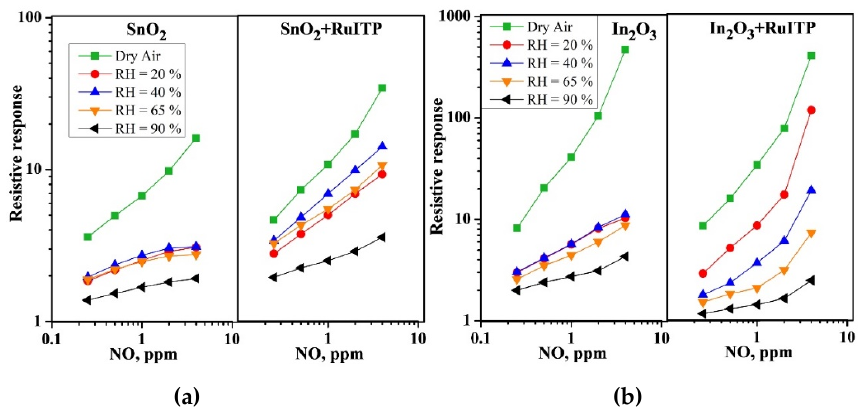
Figure 2. Resistive response of ( a ) SnO 2 , SnO 2 +RuITP and ( b ) In 2 O 3 , In 2 O 3 +RuITP samples depending on NO concentration in dry and humid air at room temperature.